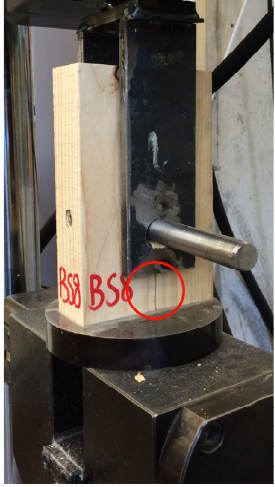
Figure 6. Camera captured the crack propagation on the surface of a reinforced specimen.